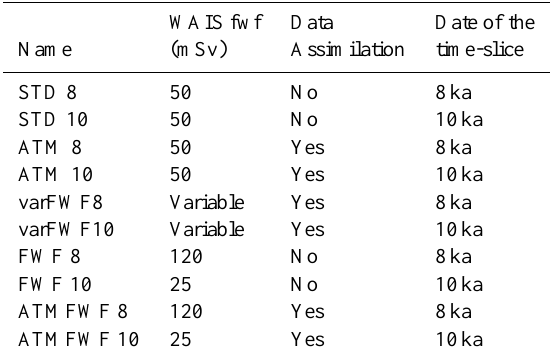
Table 2. Description of all the simulations through their name, the value of the WAIS fwf applied, the use of data assimilation (or not) and the target period (8 or